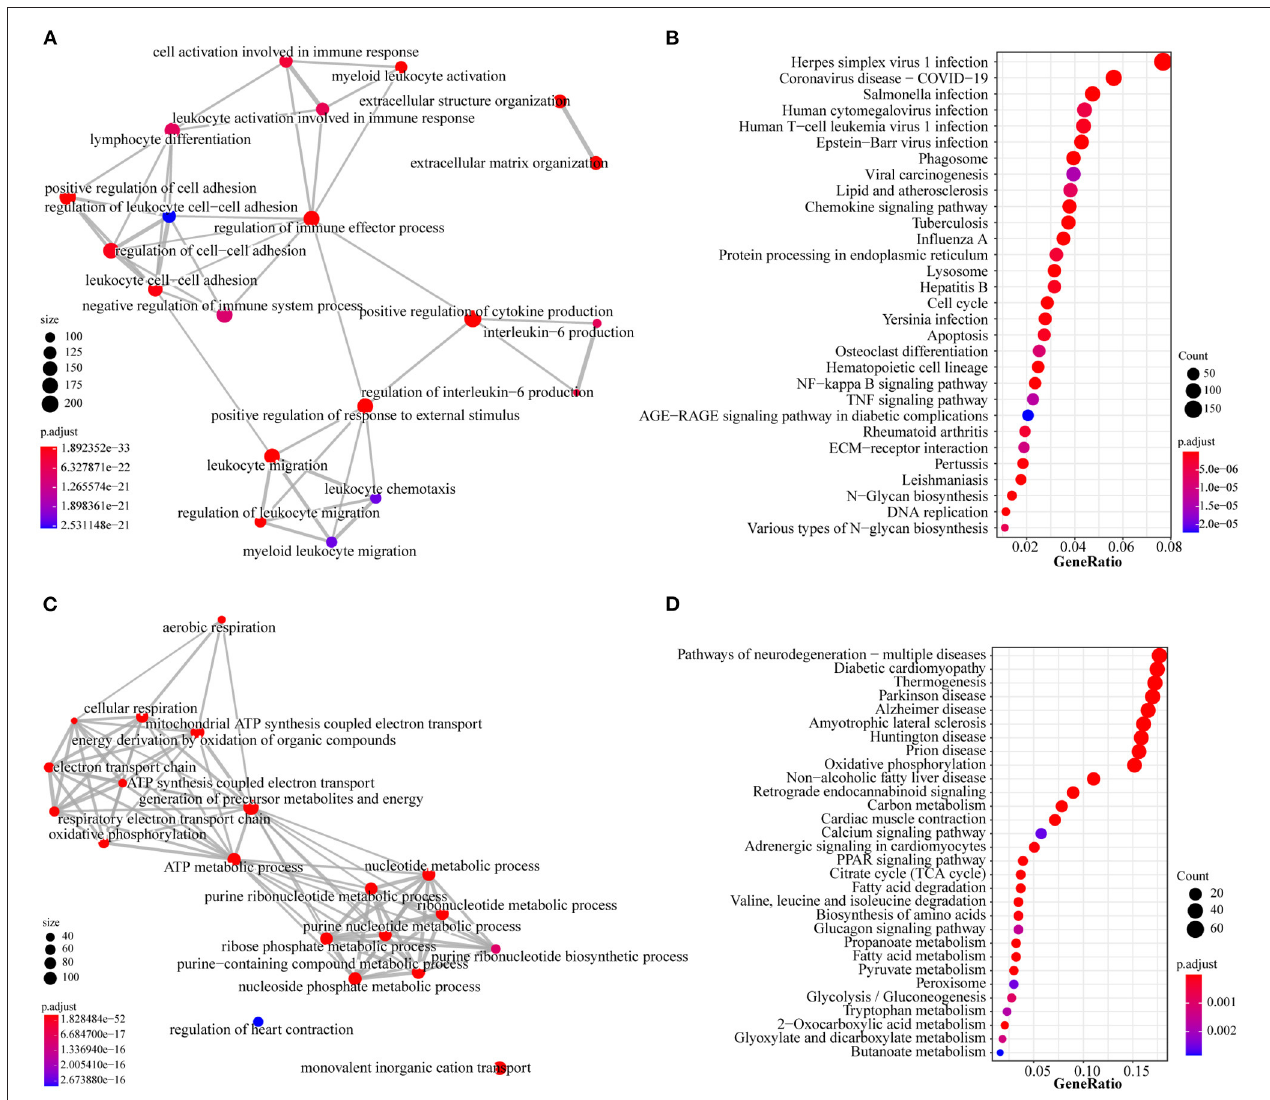
FIGURE 5 | GO and KEGG analysis of type I profiles (profiles#4 and #7) and type II profile (profile #3). (A) Top 20 items for GO analysis of type I profiles. (B) Top 30 items for KEGG pathway analysis of type I profiles. (C) Top 20 items for GO analysis of type II profile. (D) Top 30 items for KEGG pathway analysis of type II profile. Colors represent adjusted p -value, the size of the dots represents the number of genes enriched into this biological process. The thickness of the line represents how many genes are enriched in common between the two biological